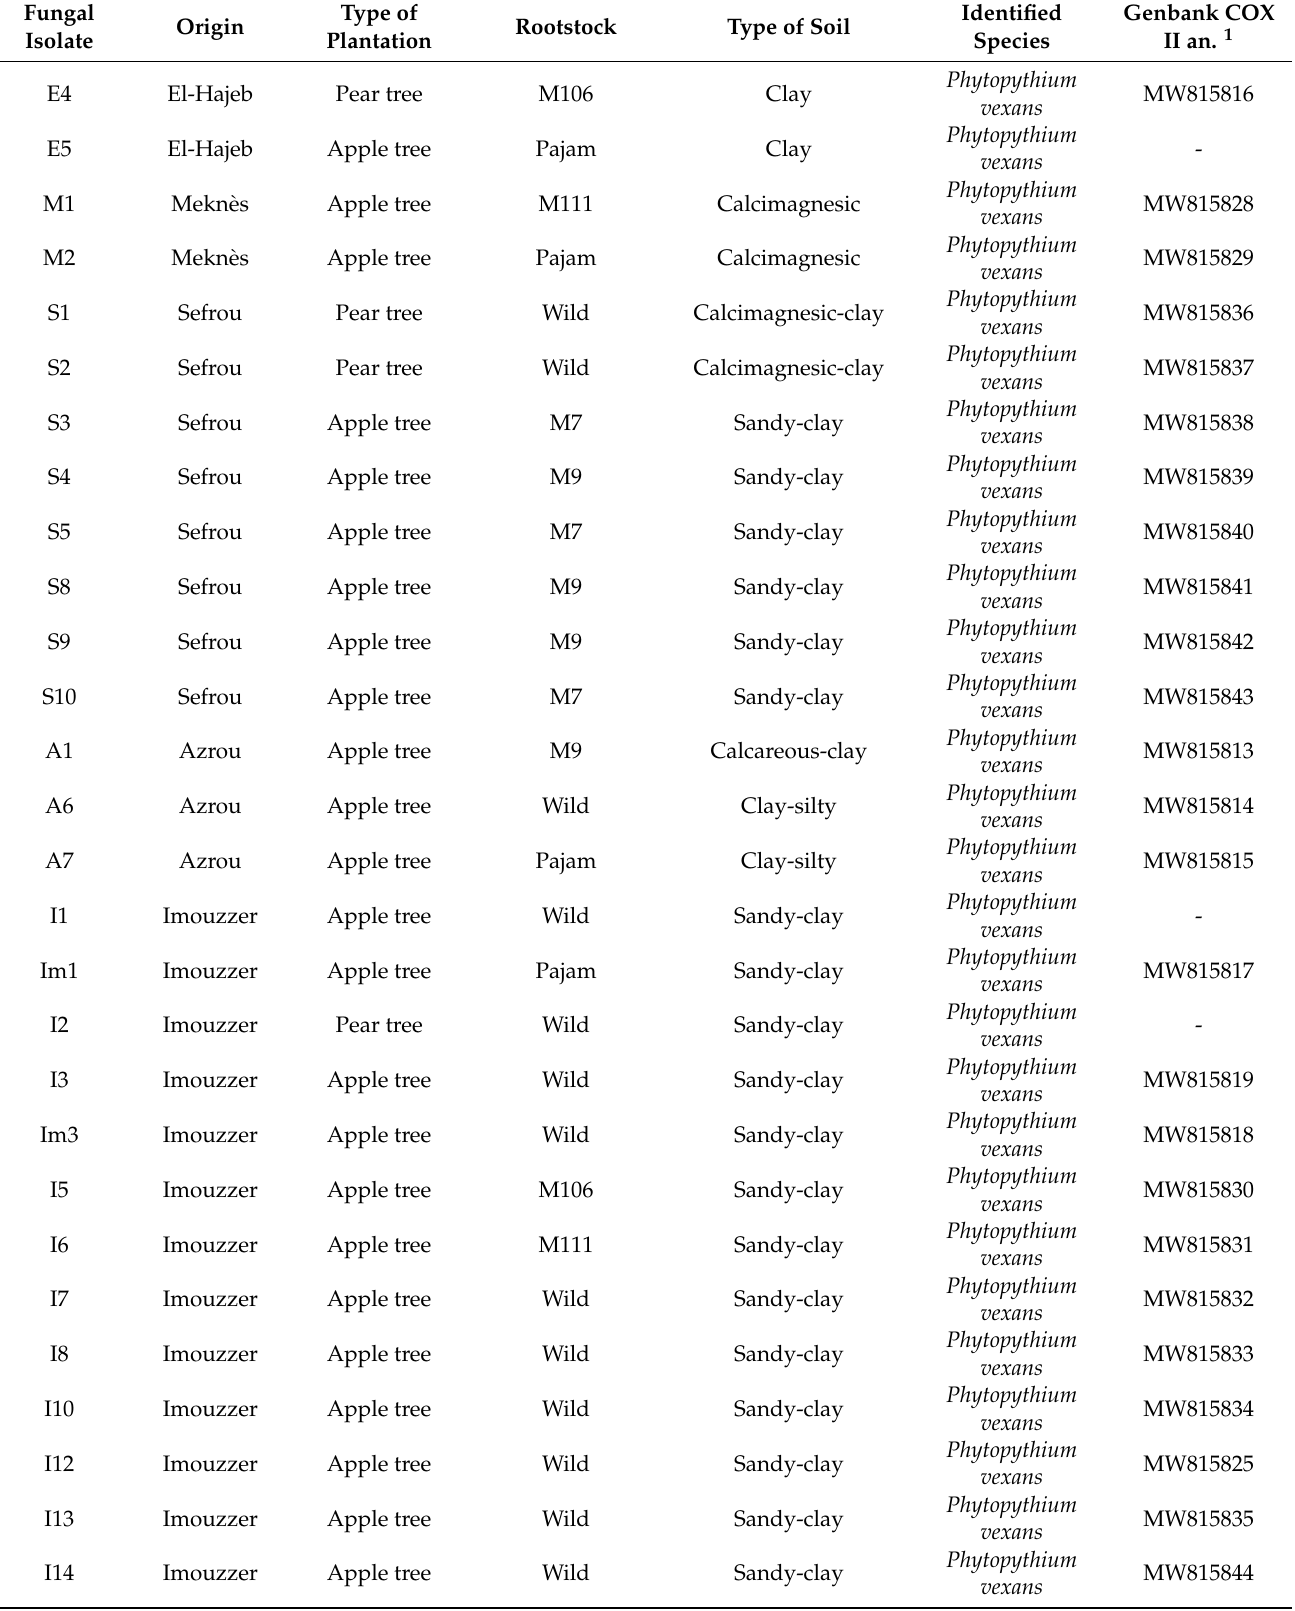
Table 1. Identity of Phytopythium vexans isolates based on morphology and COX II genes, and their GenBank accessions numbers